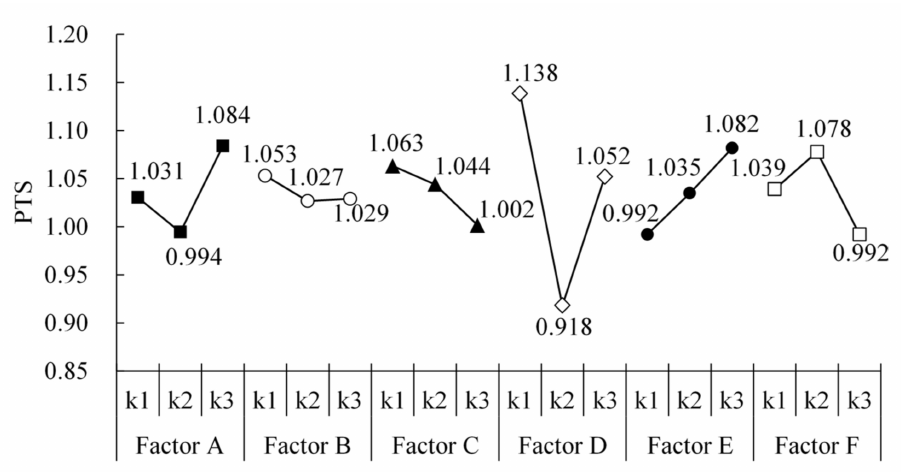
Figure 6. Correlations between the factors and the